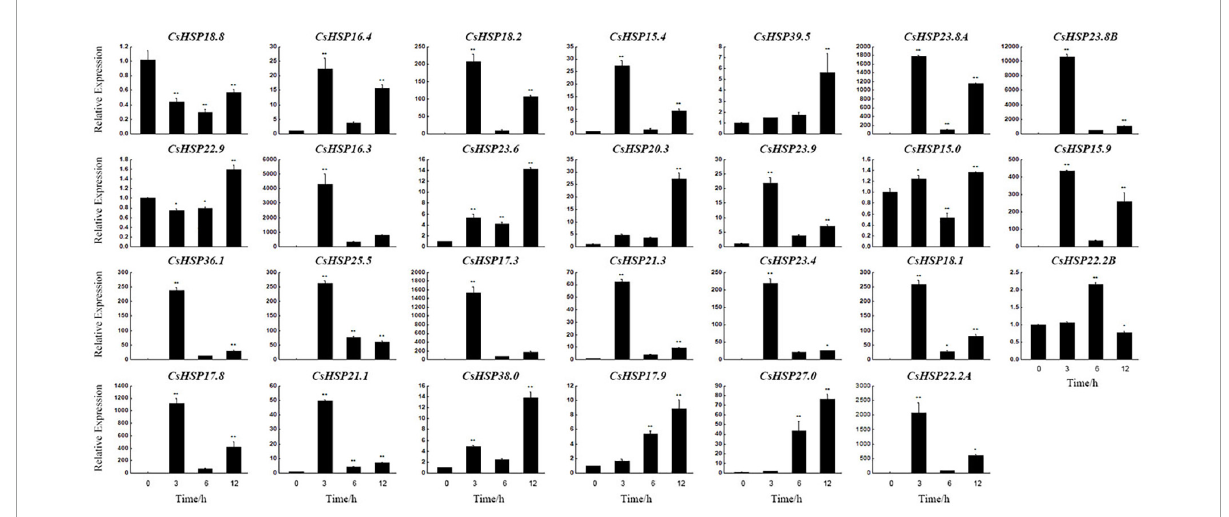
FIGURE7 The relative expression levels of cucumber HSP20 genes from qRT-PCR under heat stresses. The first true leaf of two-seedling exposed to 45 ◦ C for 0, 3, 6, and 12 h was used for analysis. All data shown are means SD of three biological replicates. The asterisks indicate the significant level (* P < 0.05, ** P < 0.01) based on a Duncan’s multiple range